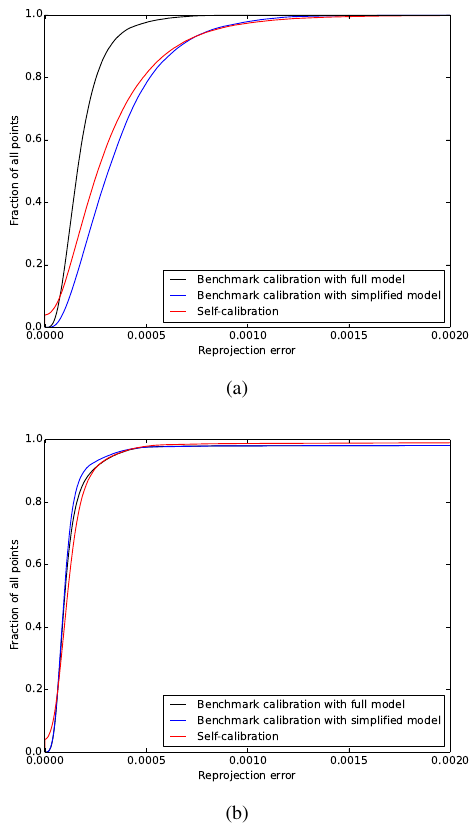
Figure 4: Cumulative distribution of the reprojection error values for all points across all views for the benchmark calibration using the full model, the benchmark calibration using the simplified model, and the self-calibration for both the 25mm lens (a) and the 50mm lens